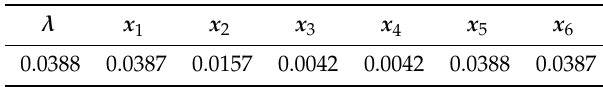
Table 9. The results of the optimization problem in Equation (26).